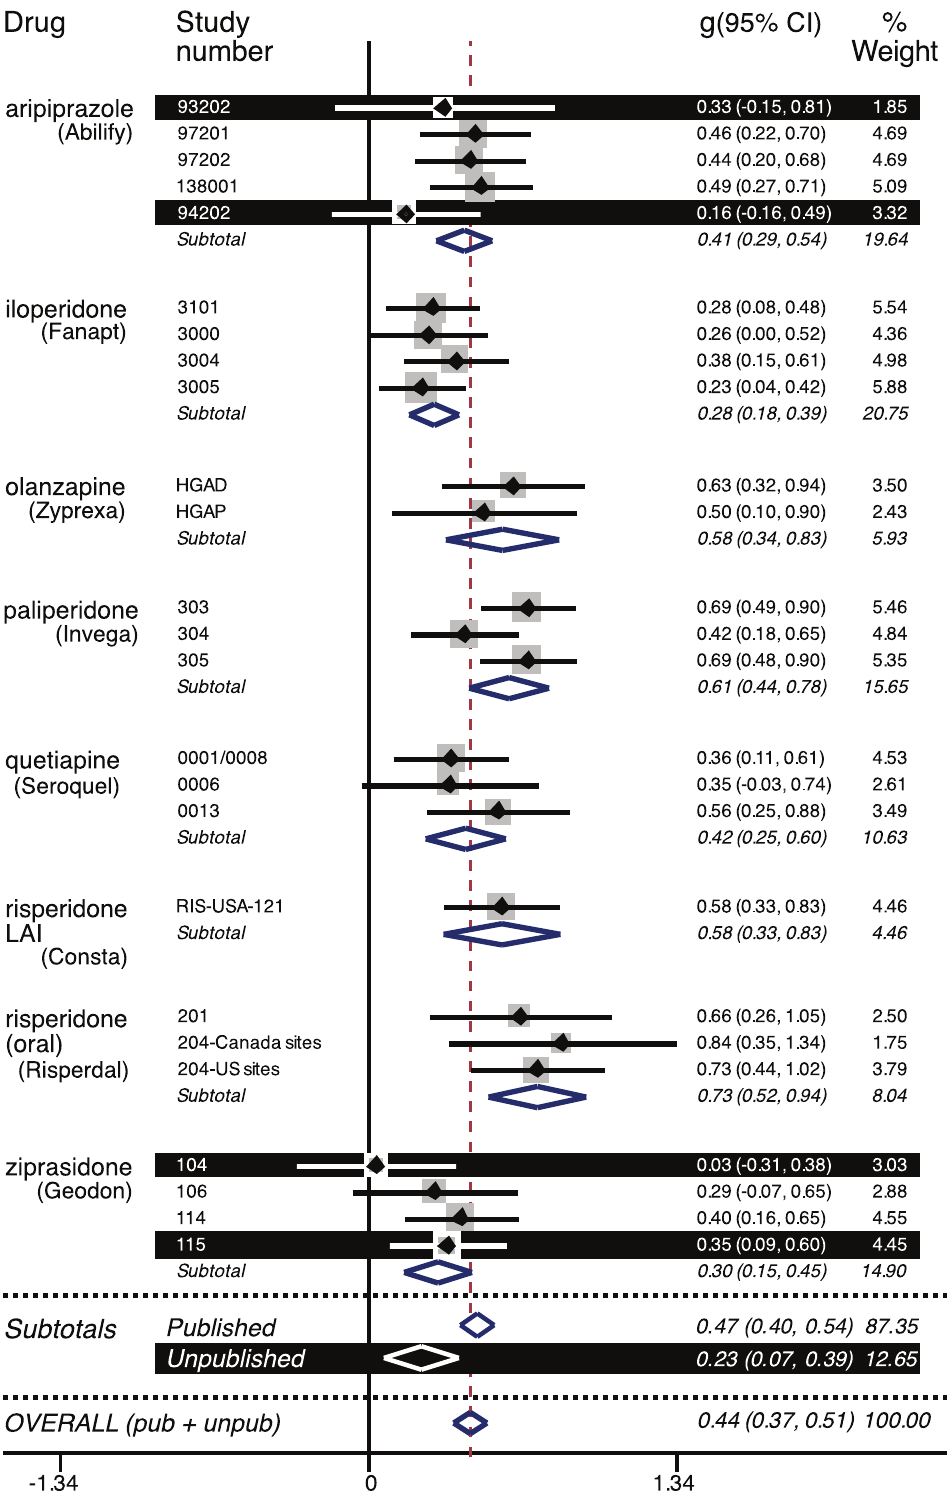
Figure 2. Forest plot of effect size (Hedges’s g ) values for FDA-registered premarketing trials of second-generation antipsychotics. The black horizontal bars highlight the four unpublished trials, three of which demonstrated no statistically significant advantage for the drug over placebo. The fourth unpublished trial showed that the drug was superior to placebo but statistically inferior to the active comparator haloperidol. Below the first dotted horizontal line, subtotal effect size and confidence interval values are shown for the subset of published trials and for the subset of unpublished trials. The difference in effect size between the published and unpublished trials was statistically significant (see text). Below the second dotted horizontal line, the FDA-based effect size is shown for all trials combined (0.44). The effect sizes shown for iloperidone trials 3000, 3004, and 3005 are based on the full sample of patients recruited, i.e., those with either schizophrenia or schizoaffective disorder, as opposed to the subset of patients with schizophrenia only (see text for details). doi:10.1371/journal.pmed.1001189.g002 PLoS Medicine |